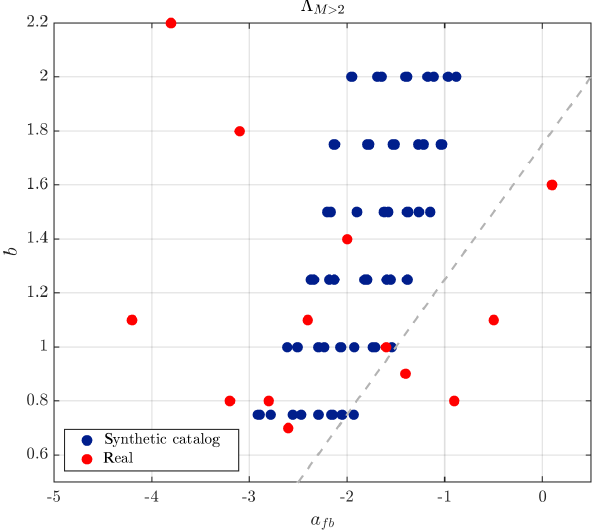
Figure 5. Distribution of a fb − b values for the synthetic cata- log together with the dataset of Table 1. In the planned injec- tion profile (see Fig. 2), the flow rate decreases progressively back to zero, meaning that this simple model cannot strictly be ap- plied. As approximation, we use max ((cid:49)V ) = 1728m 3 d − 1 instead of (cid:49)V shut-in . A direct comparison can be made between the vol- ume injected V = 18000m 3 and the equivalent τ(cid:49)V = 2880m 3 for τ = 1d and 28800m 3 for τ = 10d. The dashed line represents the upper limit of no expected seismicity of M >